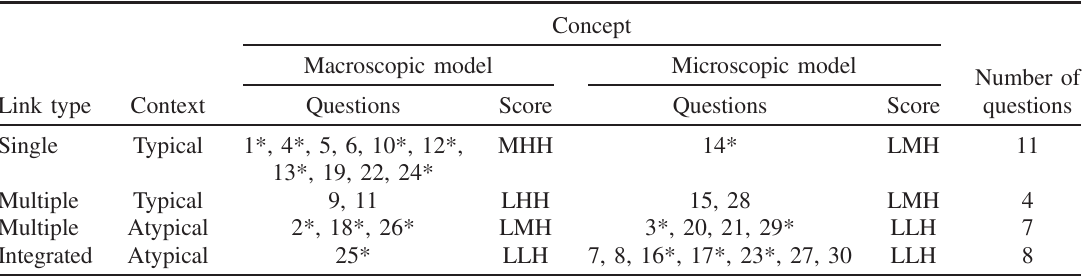
TABLE I. Question design for assessment of knowledge integration. The score patterns are predicted performance (L = M = H) for students at novice, intermediate, and expert levels of knowledge